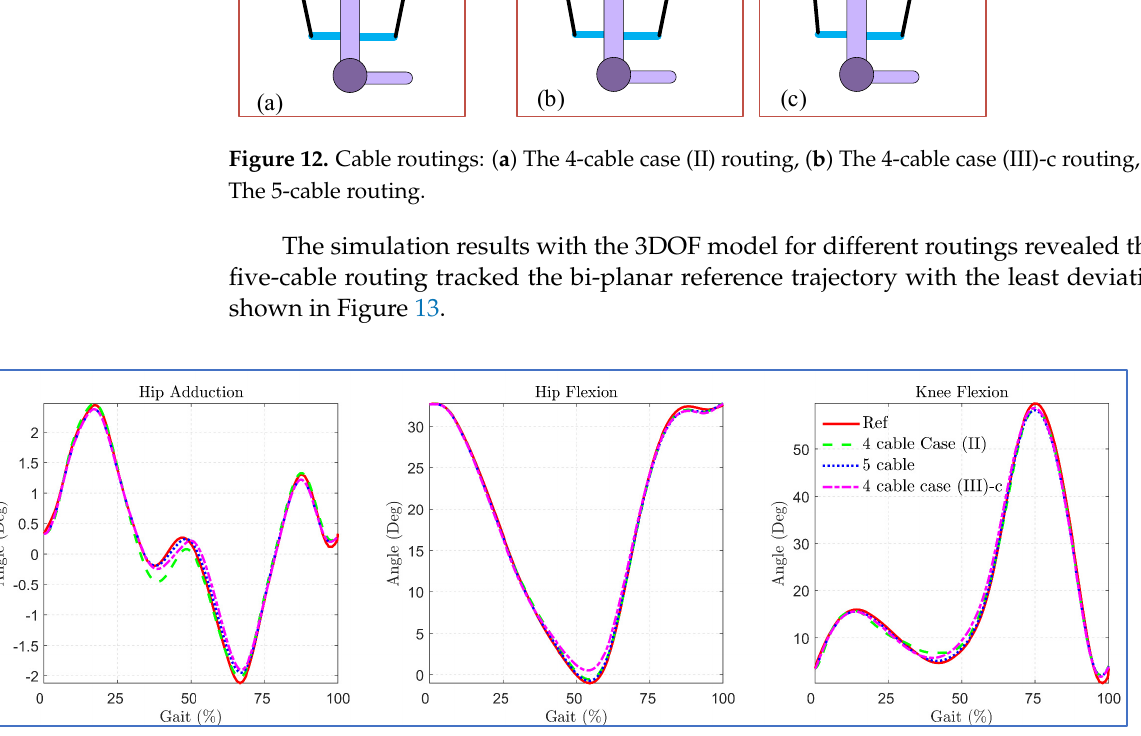
Figure 14. Joint force components induced by the applied cable tensions in each routing (SX and SY refer to shear forces along X and Y axis, CZ refers to compressive force along Z axis).